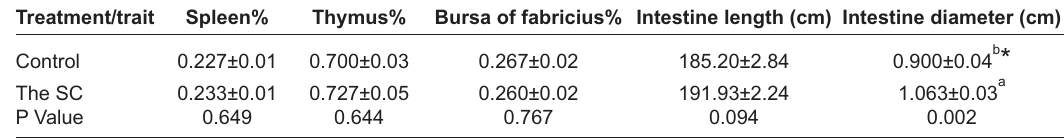
Table-4: EffectoftheSConrelativeweightsoflymphoidorgansandintestinalmorphologyinbroilerchickensat5weeksofage. Treatment/trait